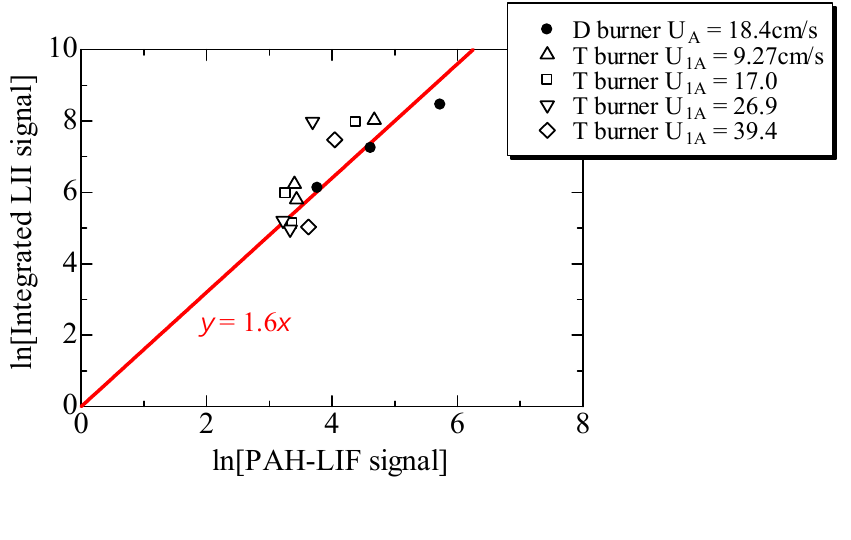
Figure 9. Correlation between natural logarithms of integrated PAH-LIF and LII